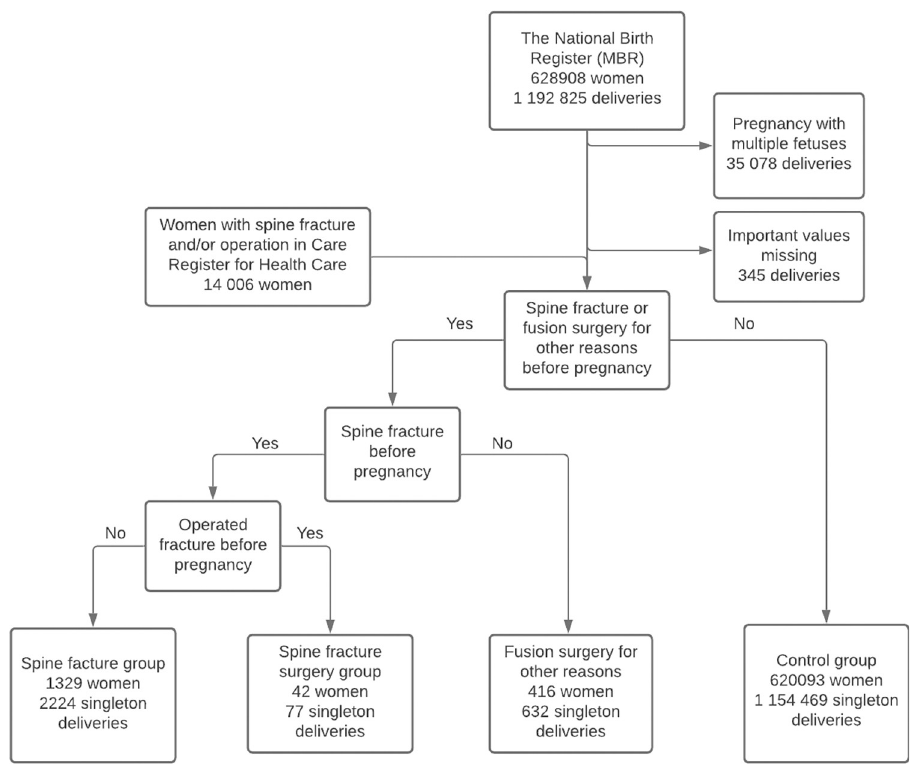
Fig 1. Flowchart of the study population. Data from the MBR were combined with data on the diagnosed spine fractures and spine operations recorded in the Care Register for Healthcare.